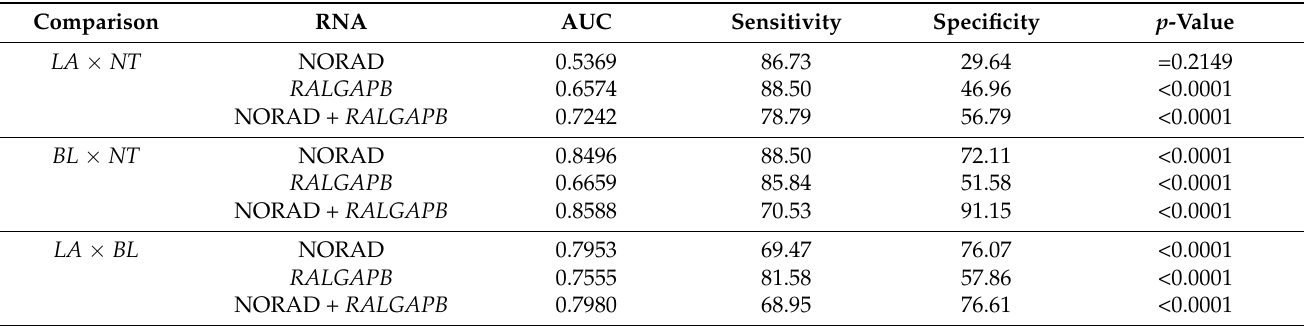
Table 2. Data about receiver operating characteristic (ROC) curves to investigate the diagnostic potential of RNAs in Lum A and Basal-like